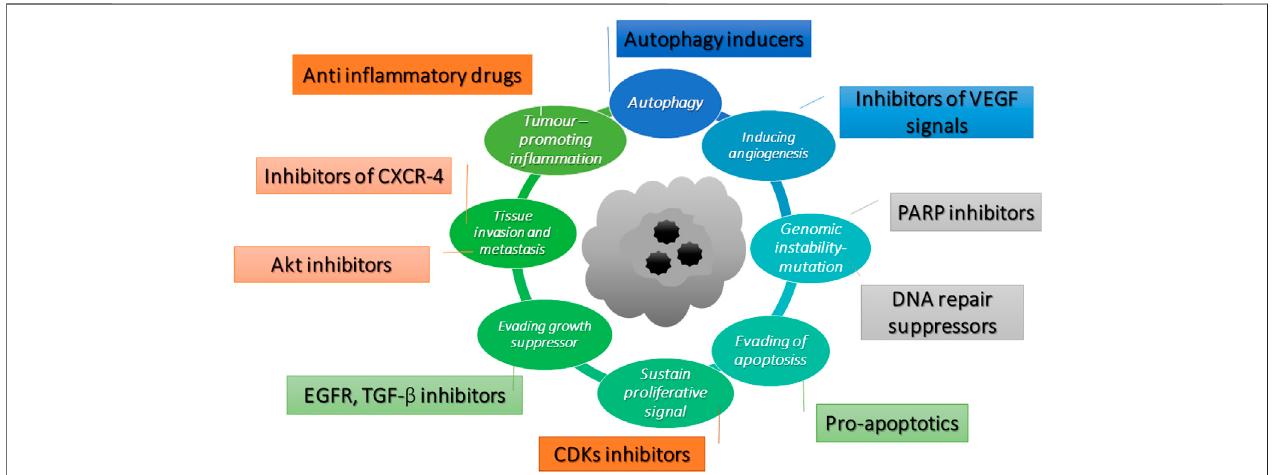
FIGURE 2 | Potential molecular targets of anti-cancer compounds adapted from Hanahan and Weinberg (2011).